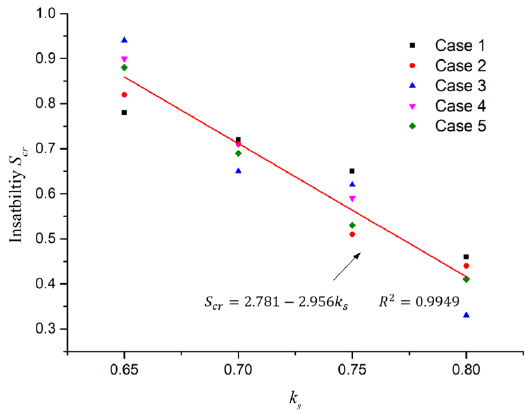
Figure 8. Instability water saturation coefficient versus axial stress coefficient.